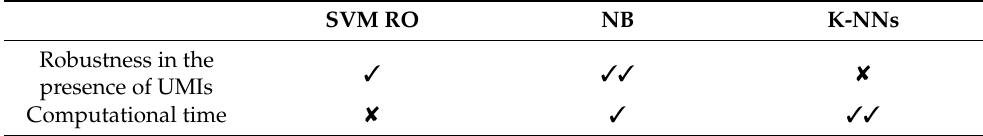
Table 6. Comparison of classifier